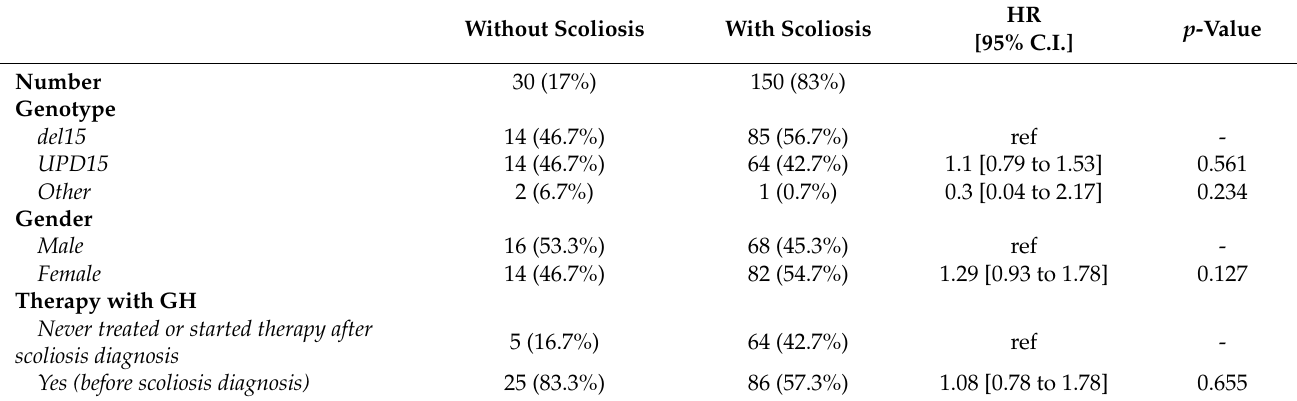
Table 2. Analysis of potential predictive factors for scoliosis in PWS